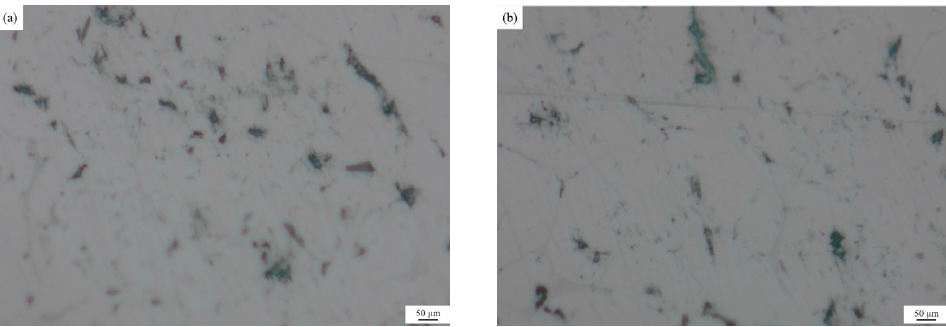
Figure 4. Metallographic pictures of the melt samples before and after the purification device when the ultrasonic wave is not turned on: ( a ) Before the purification device ( b ) After the purification device.